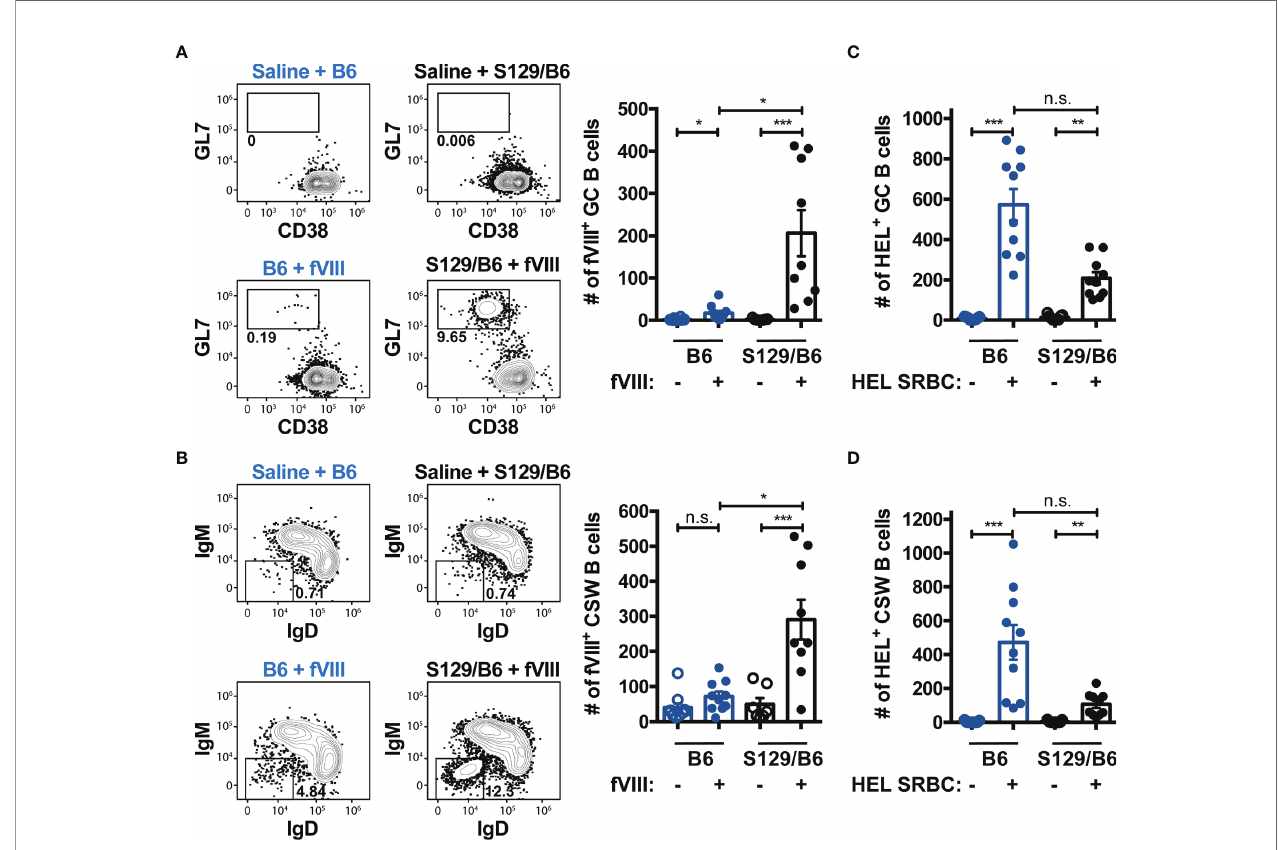
FIGURE 3 | FVIII de fi cient mice on an S129/B6 background generate a robust GC and CSW B cell response to FVIII compared to B6 FVIII de fi cient mice. (A, B) Gating strategy and graphical illustration of the absolute counts of FVIII speci fi c GC (A) and CSW (B) B cells in B6 and S129/B6 FVIII de fi cient mice administered saline or 4 weekly infusions of 1 m g FVIII, followed by a 2 m g challenge. Splenocytes were harvested and FVIII speci fi c B cells were enriched and quanti fi ed using the FVIII B cell tetramer. (C, D) Number of HEL reactive GC (C) and CSW (D) B cells 7 days post transfusion of HEL SRBCs in B6 and S129/B6 FVIII de fi cient mice. HEL reactive B cells were enriched and enumerated using the HEL B cell tetramer. Error bars represent ± SEM. Statistics were generated using a Kruskal-Wallis with a Dunn ’ s multiple comparison post-test. There were 7-10 mice per group. The data demonstrated are the combined results from 2 experiments. *p < 0.05, **p < 0.01, ***p < 0.001, and n.s. indicates not signi fi